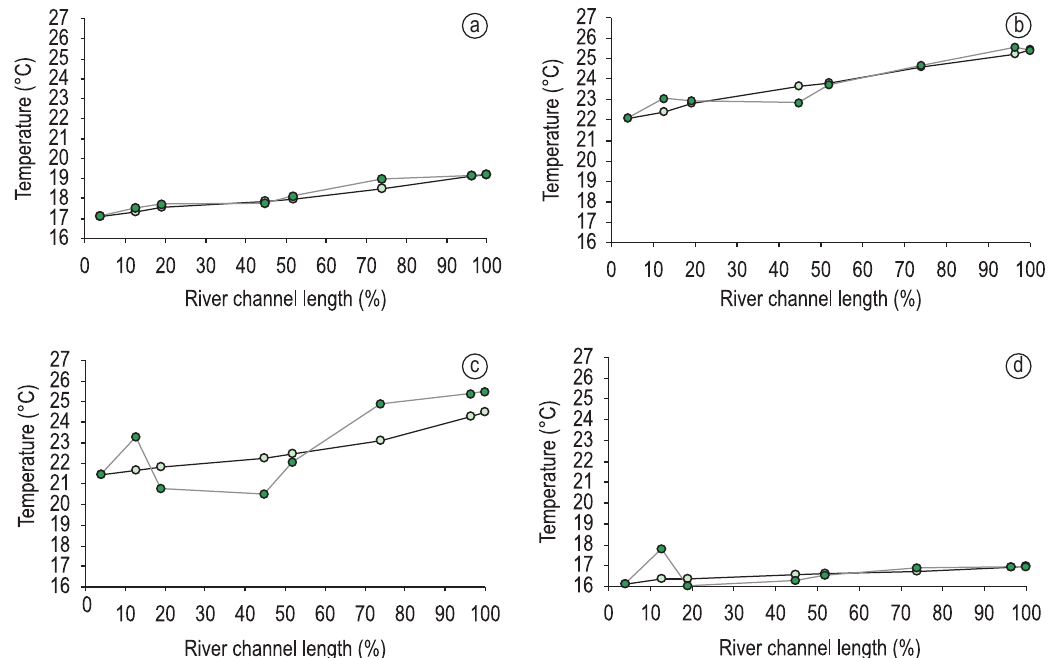
Figure 4. Water temperature variation (ºC) in Canha River, during the spring (a - September), summer (b - January), autumn (c - April) and winter (d - July) periods, respectively. ● : observed water temperature; “ ● ”: simulated water